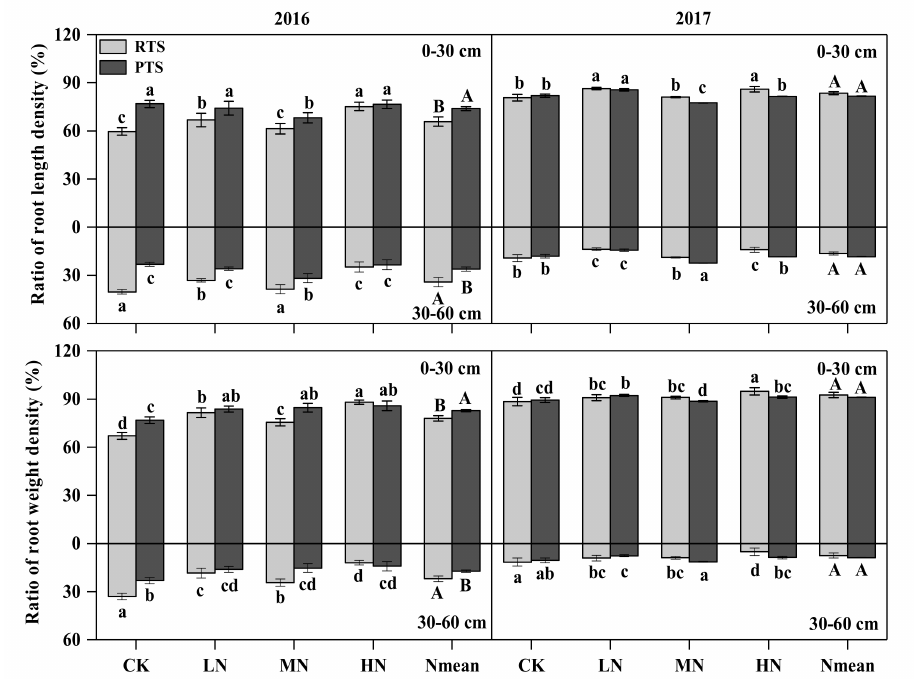
Figure 5. Response of ratios of root length density and root weight density to tillage with straw incorporation and N treatment in 2016–2017. RTS, rotary tillage with straw incorporation; PTS, plow tillage with straw incorporation. CK, LN, MN, and HN indicate 0, 112, 187, and 262 kg N ha − 1 applied, respectively. Nmean, the mean values of di ff erent N. Di ff erent uppercase and lowercase letters indicate significant di ff erences for ratios of root length density and root weight density between tillage with straw incorporation and N treatment for p < 0.05 level,